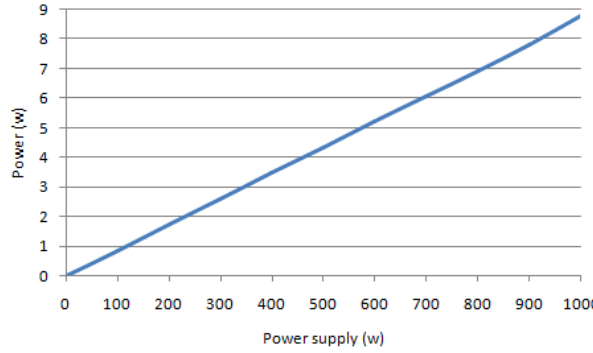
Figure 3. Variation of received power vs. power supply.